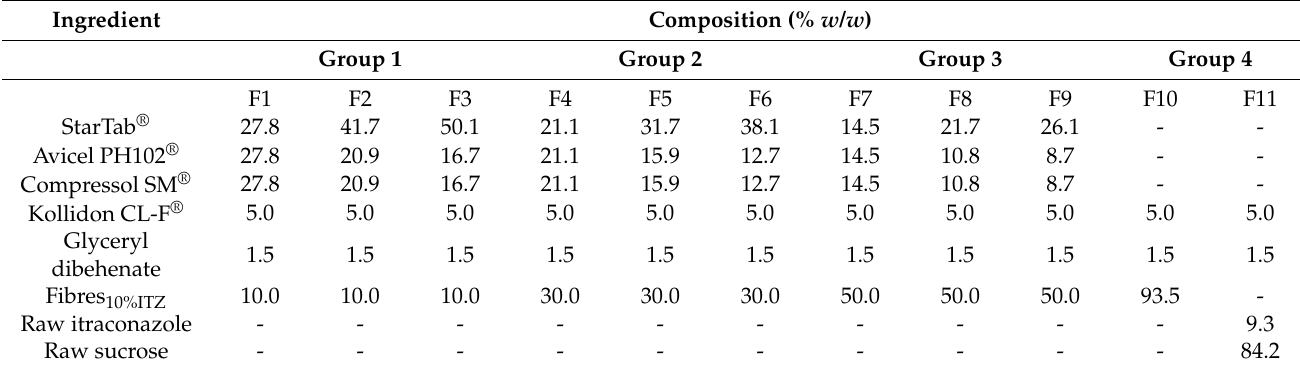
Table 1. Tablet compositions for the 11 different batches (F1-F11) based on the 10% itraconazole- loaded microfibres (Fibres 10%ITZ ). Values are rounded to one decimal place, so they may not sum to exactly